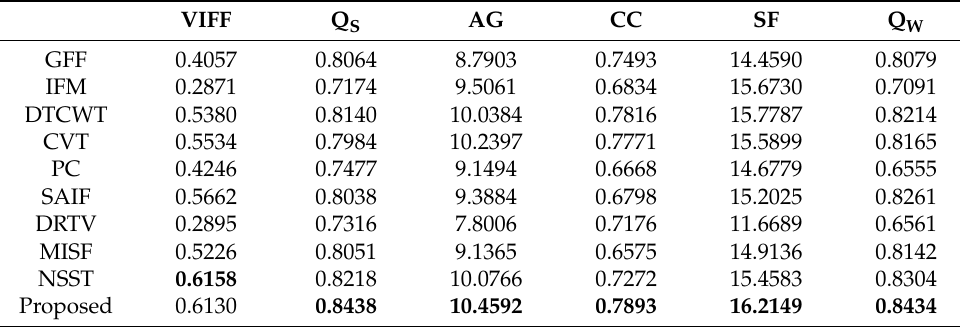
Table 1. The objective evaluation of the methods in Figure 4.